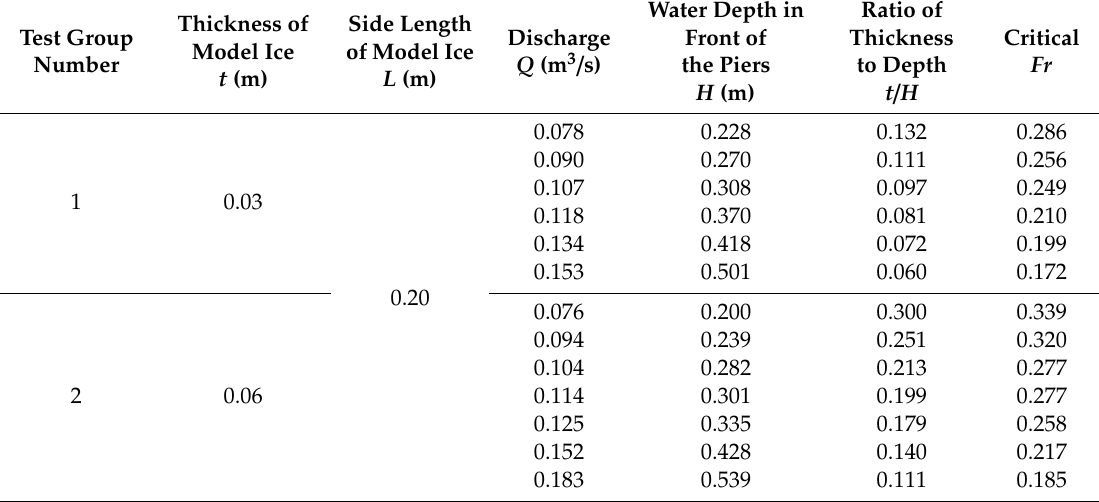
Table A3. At the same side length of ice, the relationship between critical Fr and t / H at di ff erent thickness of